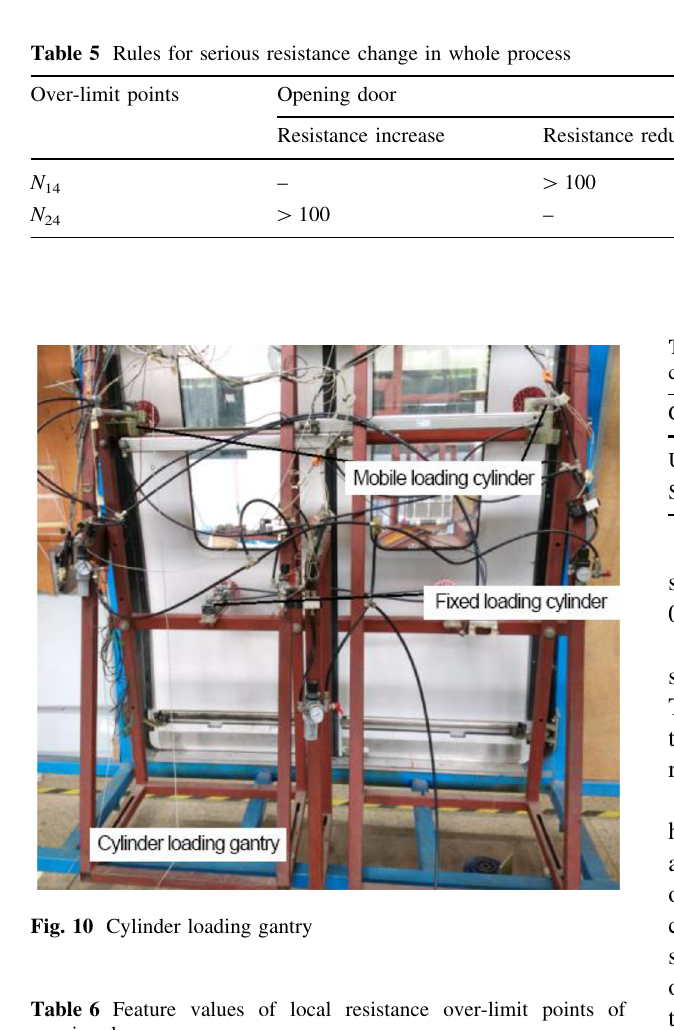
Table 6 Feature values of local resistance over-limit points of opening doors Cylinder loading condition